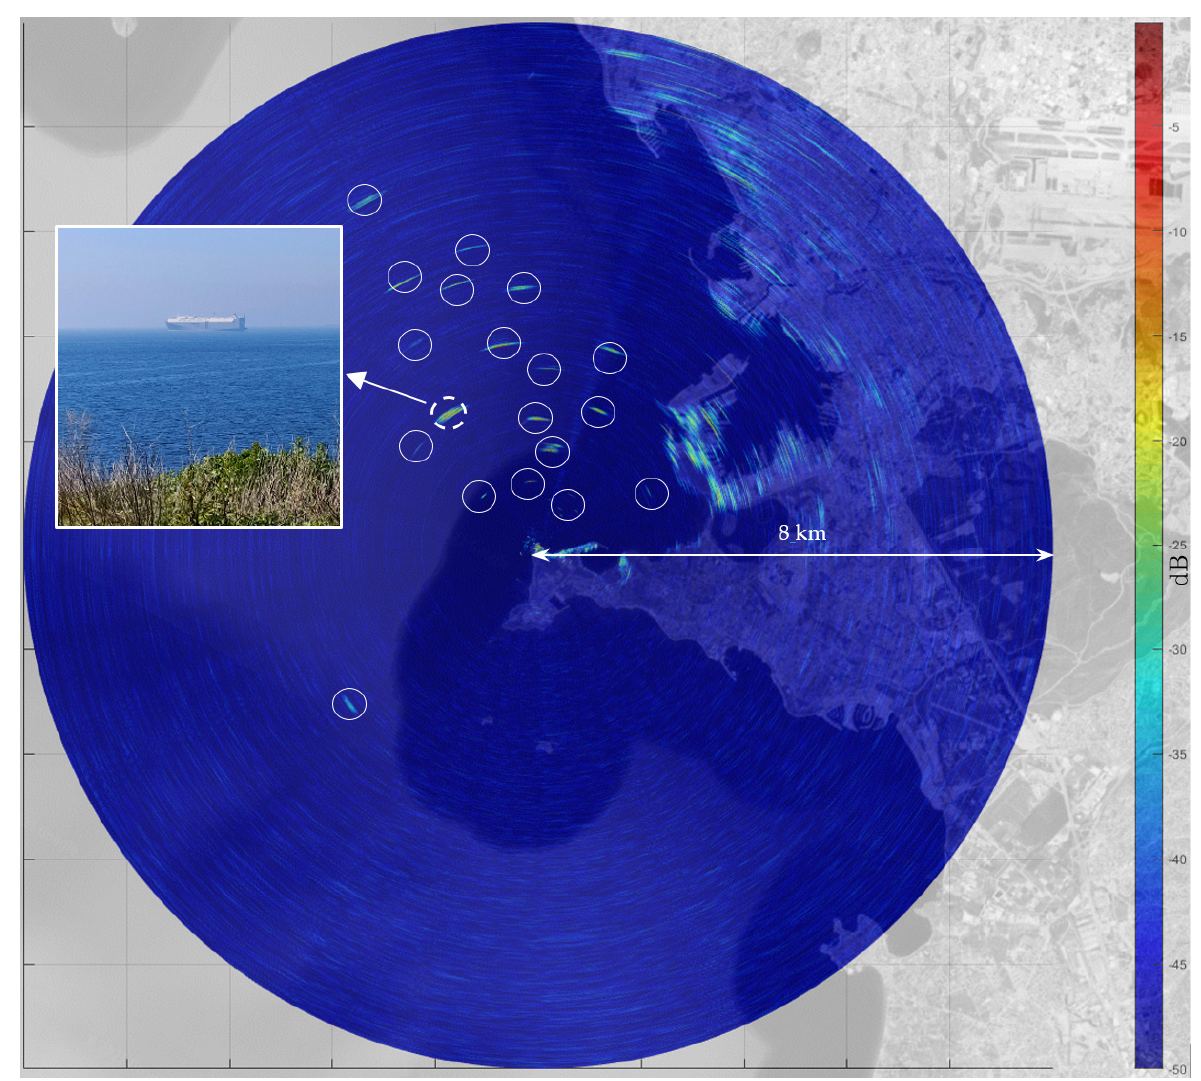
Figure 18. A surveillance scan view obtained using COSPAR signal. Ship targets are encircled in white. The large ship target marked with dashed white circle is used for range profile analysis.